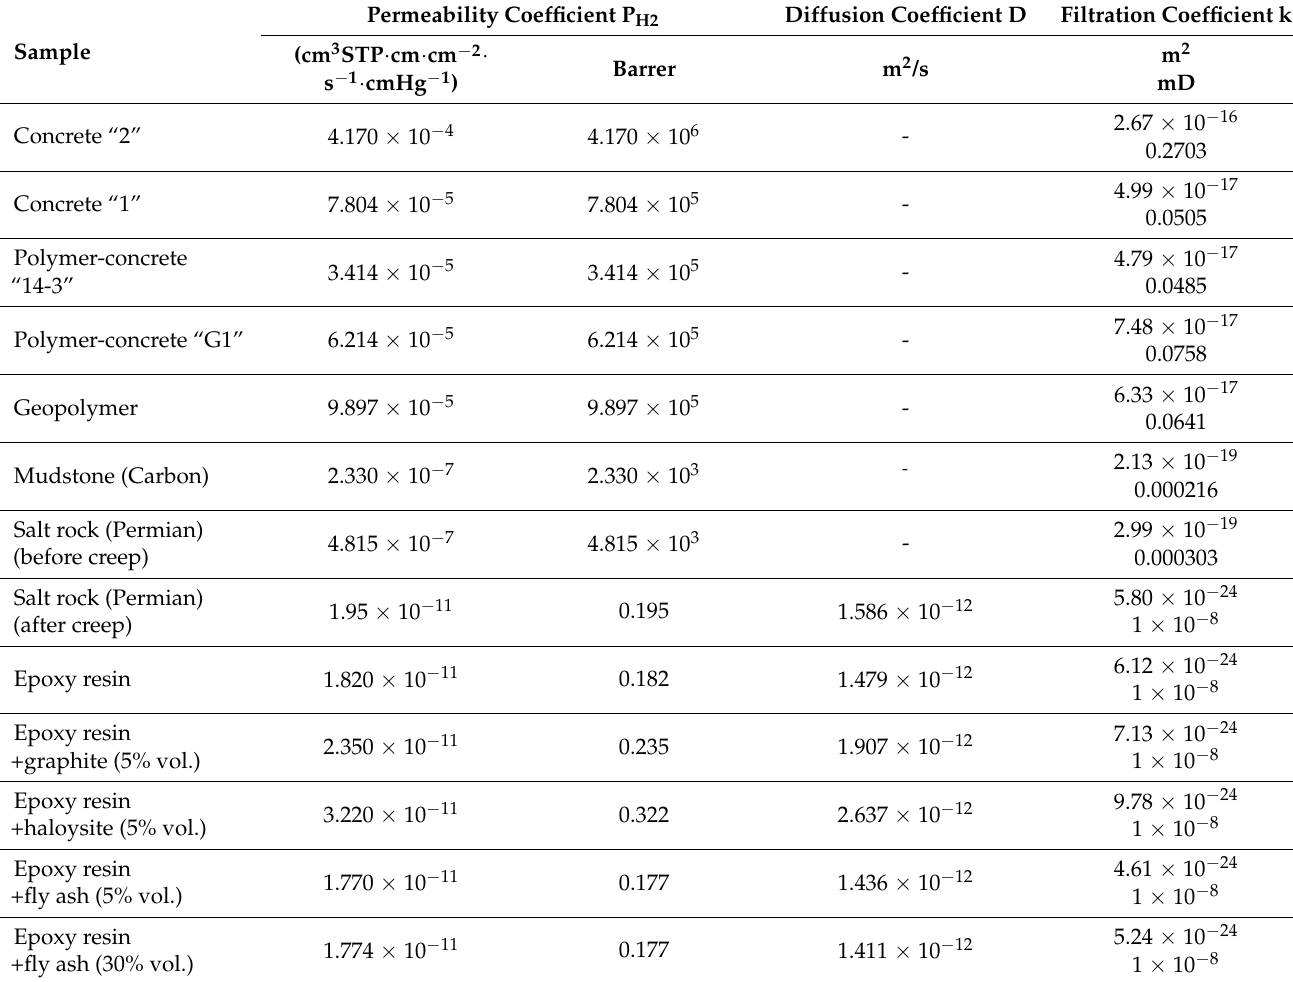
Table 2. Gas permeability of investigated